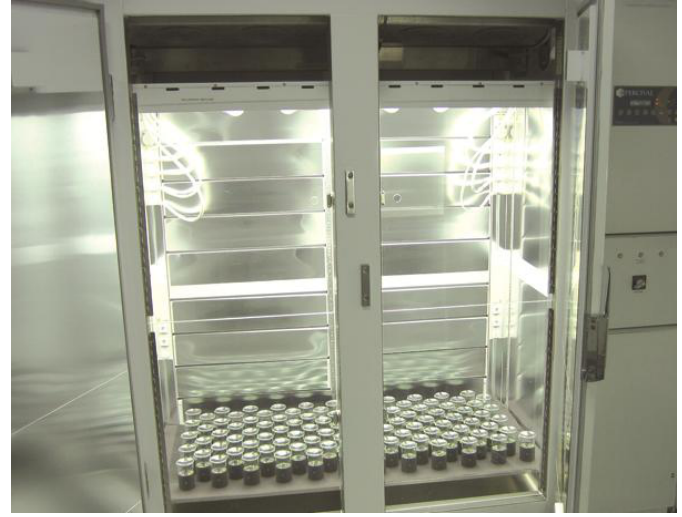
FIGURE 1 . Experimental setup of a single experiment in the growth chamber (100 beakers with L. gibba ). For every experimental parameter (n = 20 in total), five replicates were used and allocated in a fixed-blocked randomization scheme. The 20 experimental conditions consisted of 18 letter-coded samples and two additional open controls, one with unimpaired duckweed and one with duckweed impaired during the entire experimental interval (the latter two controls were not used for the statistical